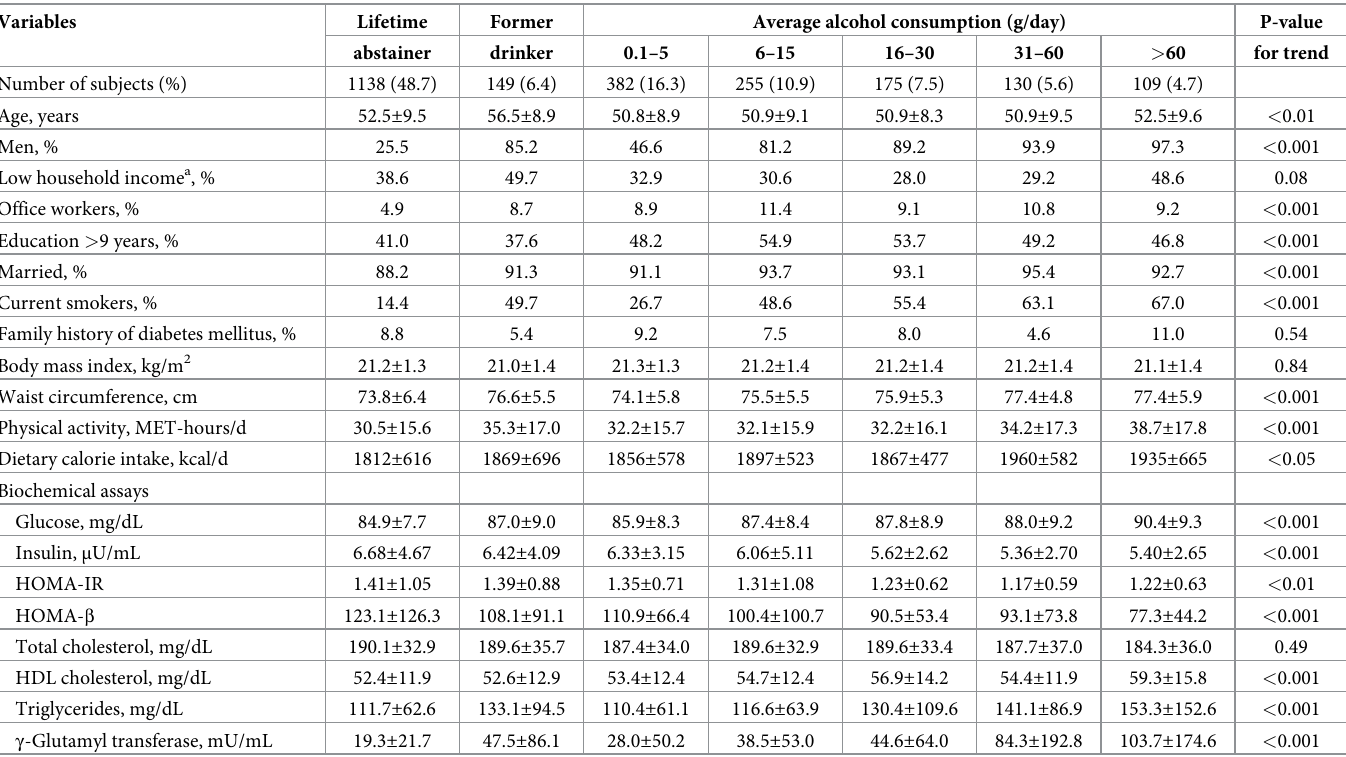
Table 1. Baseline characteristics of 2,338 study subjects across alcohol consumption